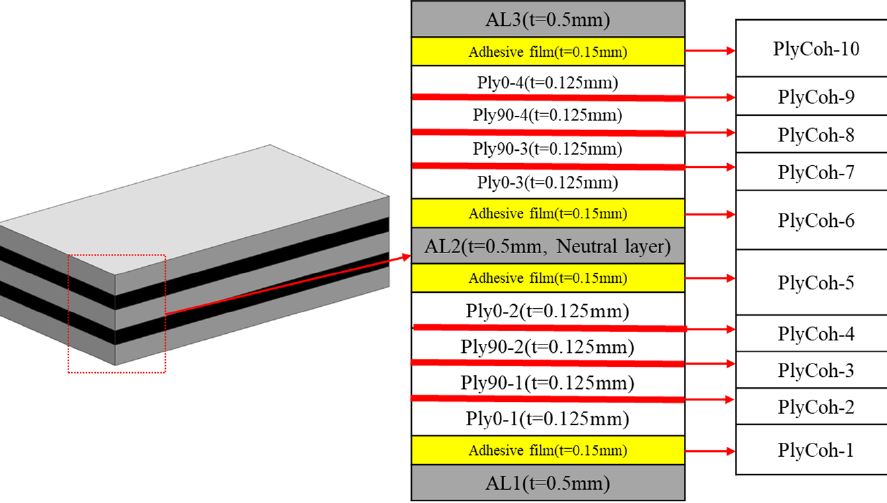
Figure 1. Schematic diagram of CARALL specimens.